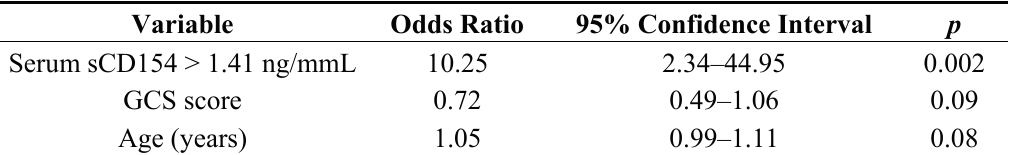
Table 3. Multiple binomial logistic regression analysis to predict 30-day mortality.